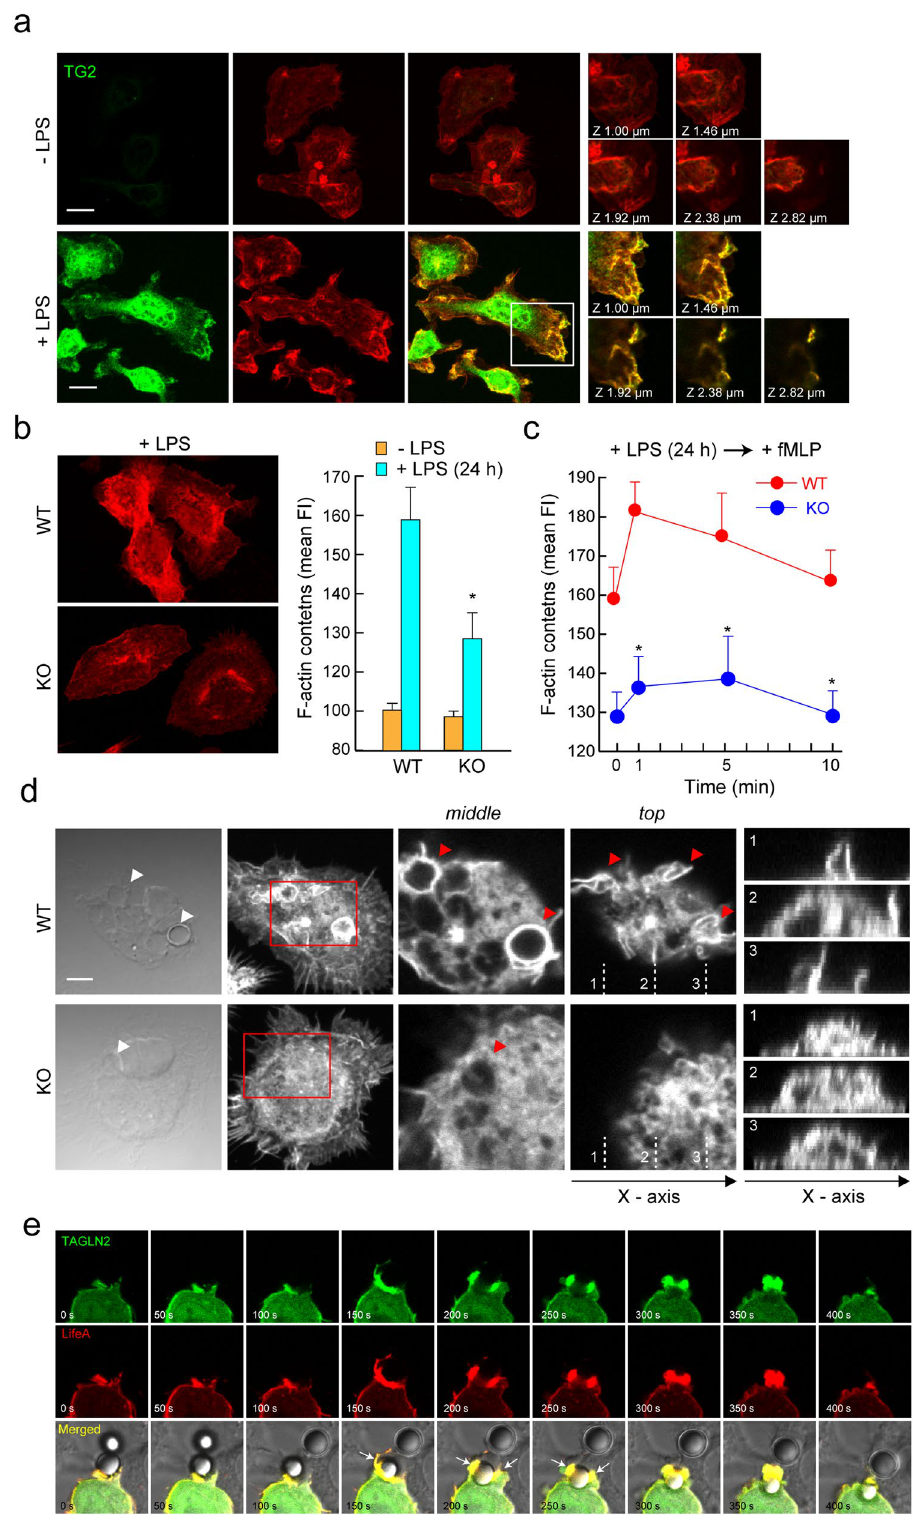
Figure 3. Impaired actin polymerization in TAGLN2-deficient macrophages. ( a ) TAGLN2 is localized at the actin-rich membrane ruffles. Freshly isolated peritoneal macrophages were incubated with or without LPS (1 μ g/mL) for 24 h, and were serum-starved for 3 h. Cells were treated with fMLP (200 nM) for 2 min, fixed, stained with anti-TAGLN2 antibody and TRITC-phalloidin, and observed by confocal microscopy. Scale bars, 10 μ m. Single z-slices were shown in basal and dorsal views where TAGLN2 and F-actin colocalize in ruffles. The boxed areas (white) are represented as zoomed images in the right micrographs. ( b ) WT or TAGLN2 − / − macrophages were stimulated with LPS for 24 h and analyzed for their actin contents and polymerization by confocal microscopy (left) flow cytometer (right) after stained with TRITC-phalloidin. Data are represented